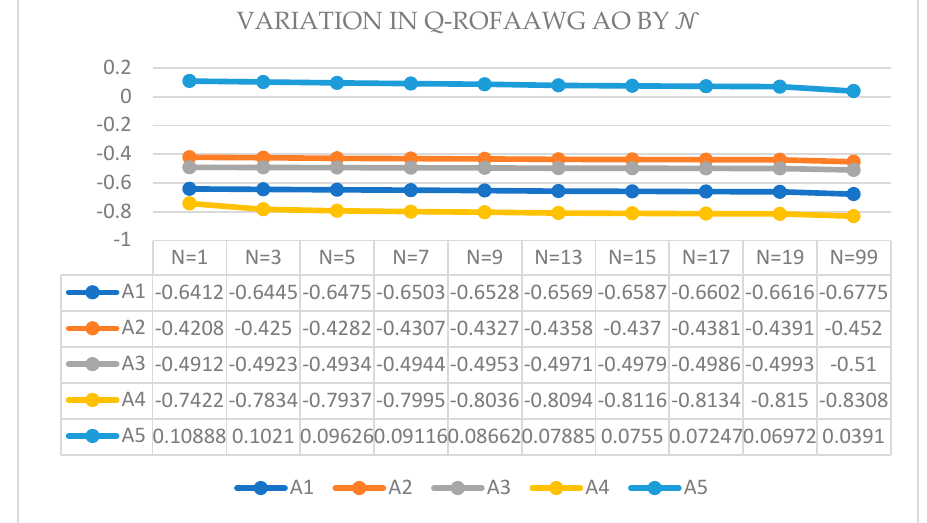
Figure 2. The graphical representation of score value, variation by 𝒩 .